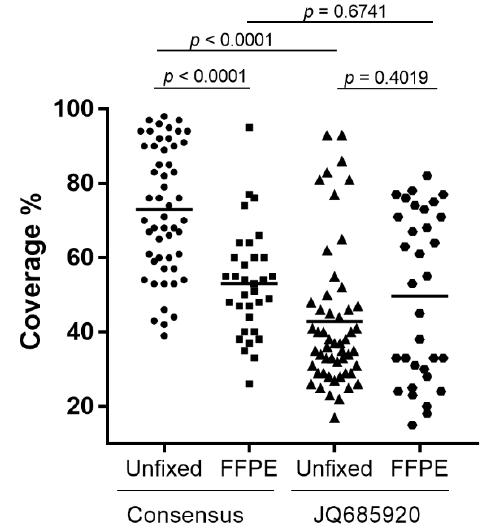
Figure 4. Scatter plots of the percentage coverage of the rabies virus genome of Ampliseq reads for all samples using either the consensus (Figure S1) or JQ685920 sequences for reference-guided assembly. Unfixed and FFPE samples are illustrated separately. Horizontal bars indicate the average value in each group and the calculated p -values between each group are shown above the diagram.